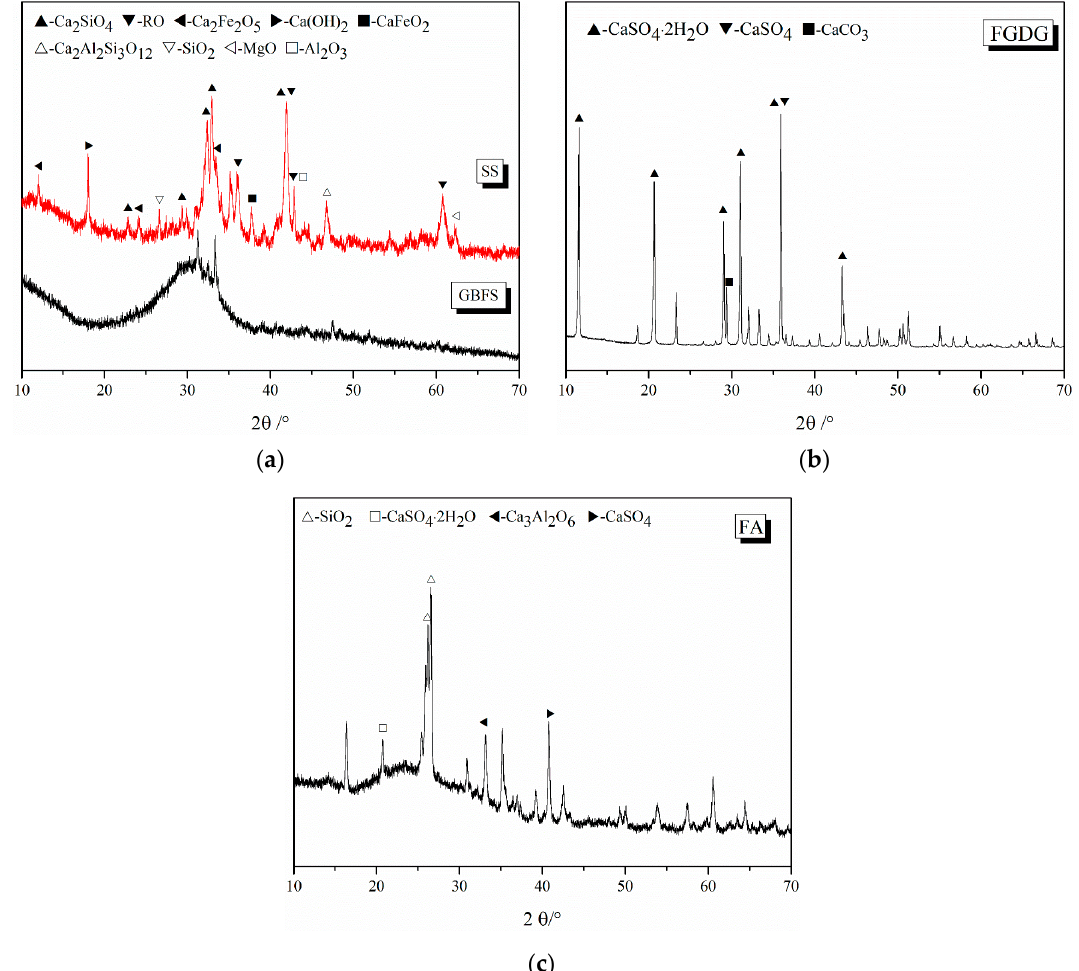
Figure 2. XRD pa tt erns of ( a ) SS and GBFS, ( b ) FGDG and ( c ) FA. Figure 2. XRD patterns of ( a ) SS and GBFS, ( b ) FGDG and ( c ) FA.